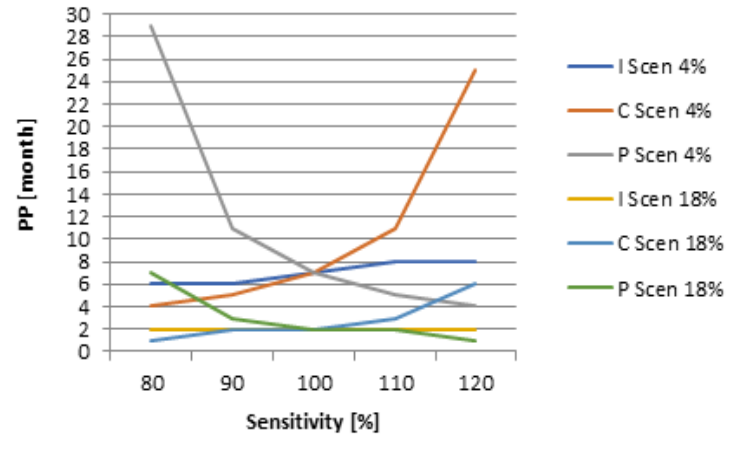
Figure 5: Graph sensitivity I, C, R to IRR in scenario 4% and 18%